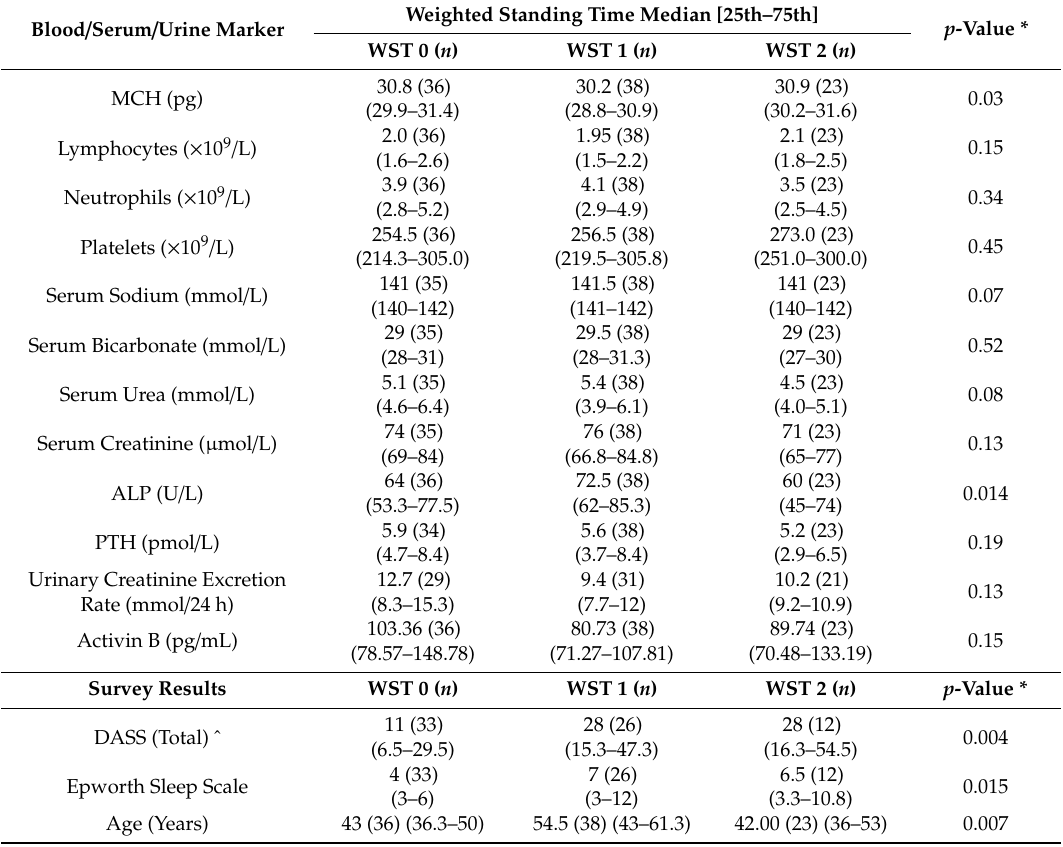
Table 4. Comparison of pathology markers, questionnaire results and serum Activin B for ME / CFS sub-cohorts stratified by the Weighted Standing Time (WST) symptom severity scale, including a control cohort of healthy participants. WST 0 and 1 (Table 2) data were pooled prior to analysis. Results summarised as medians and 25th–75th